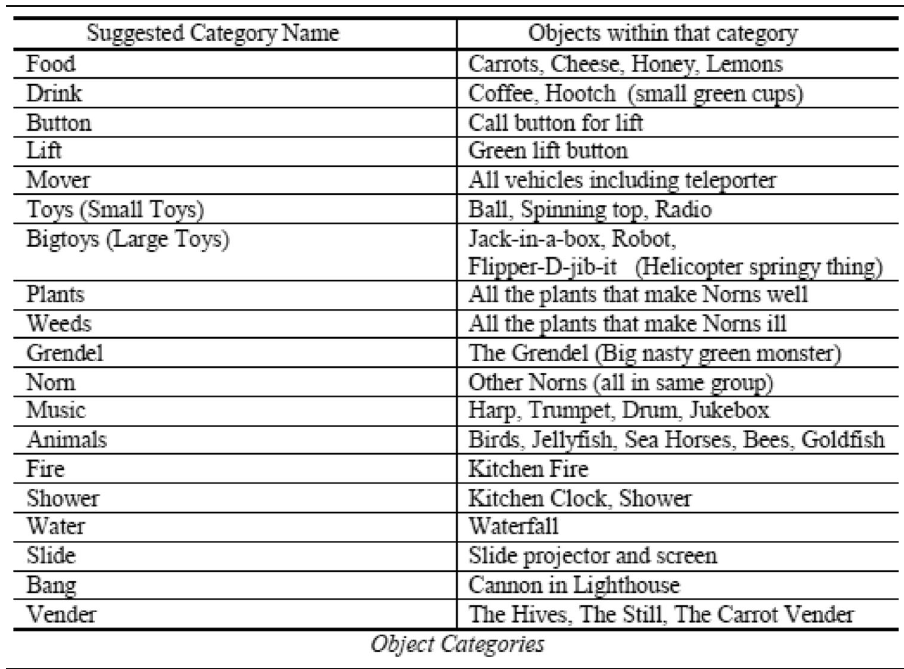
Bunt and Gouws Smart Learning